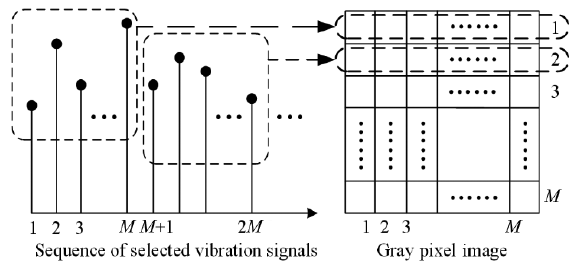
Fig. 2 Signal-to-image